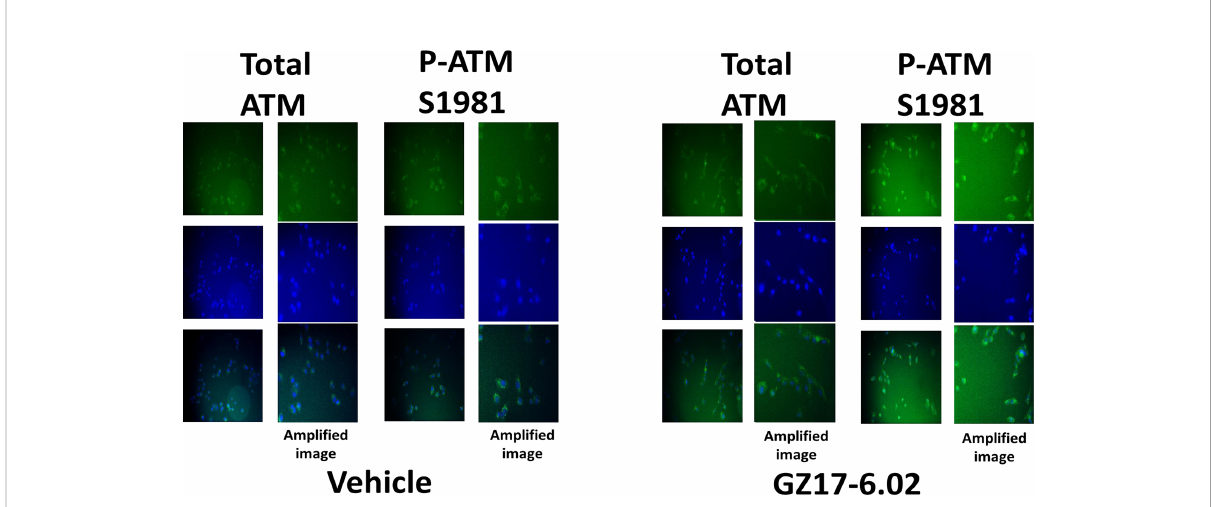
FIGURE 13 GZ17-6.02 rapidly activates ATM proteins localized around and outside of the nucleus. Cells were treated with vehicle control or with GZ17- 6.02 (2 m M). Cells were fi xed 6h after drug exposure. Cells were fi xed in situ, permeabilized, stained with the indicated validated primary antibodies and imaged with secondary antibodies carrying red- and green- fl uorescent tags. Cells were co-stained with DAPI. Total ATM protein levels and ATM localization within the cell did not alter over the time course (data not shown).